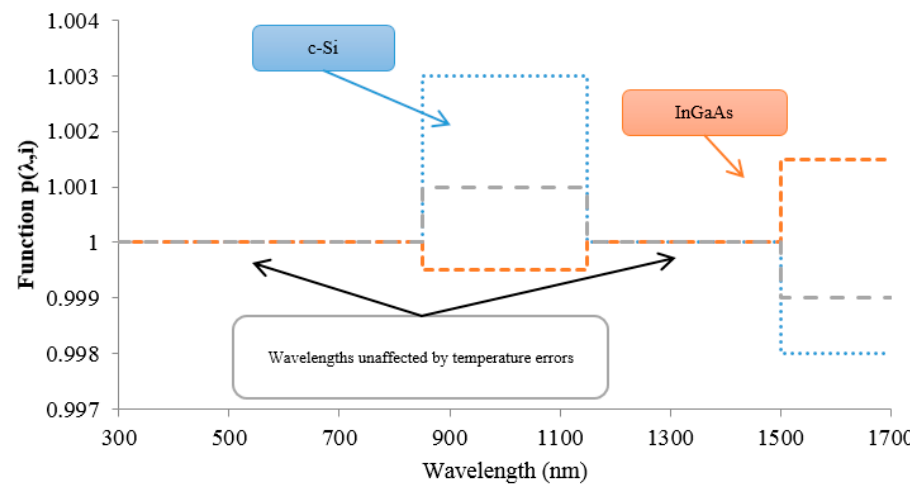
Figure 8. Weighting factor generated in 3 different Monte Carlo runs to adjust the spectrum in the InGaAs and c-Si regions independently. The weighting factor is always equal to one except in the interested wavelengths, where the spectrum is scaled up or down depending on the random number sampled from the Gaussian